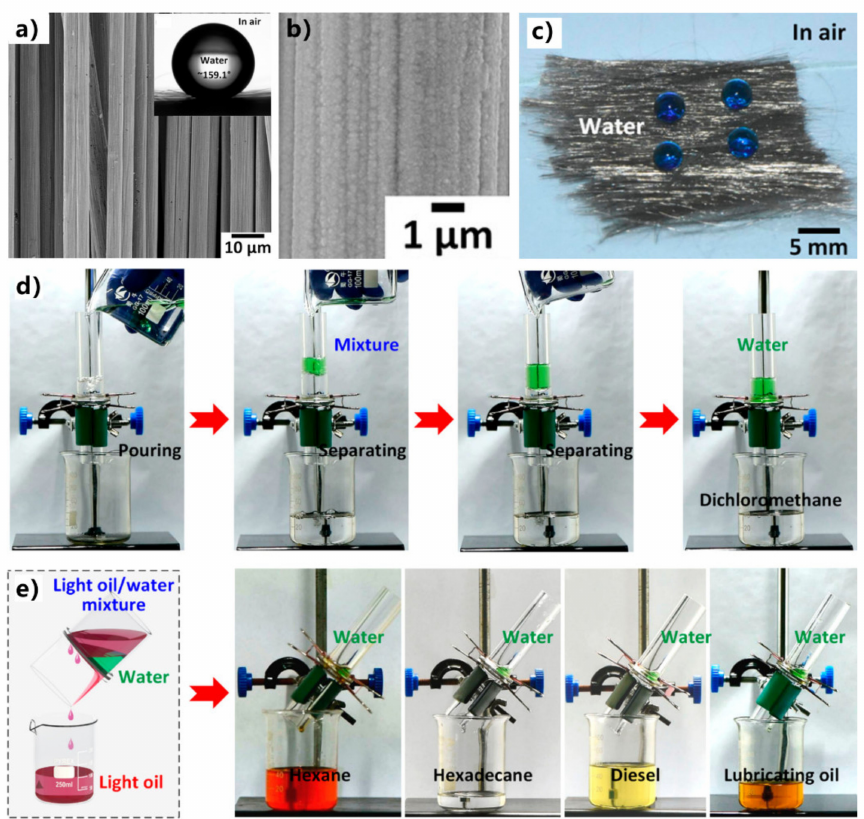
Figure 13. Oil/water separation based on the superhydrophobic nickel-coated carbon fiber. ( a , b ) Microstructure of the superhydrophobic carbon fiber coated with nanoscale nickel grains. Inset of ( a ): Shape of a water droplet on the as-prepared carbon fibers. ( c ) Photo of water droplets on the as-prepared carbon-fiber sheet. ( d ) Separation of water and heavy oils (such as dichloromethane). ( e ) Separation of the water and light oils (hexane, hexadecane, diesel, and lubricating oil). Reprinted with permission from ref. [242]. Copyright 2020, American Chemical